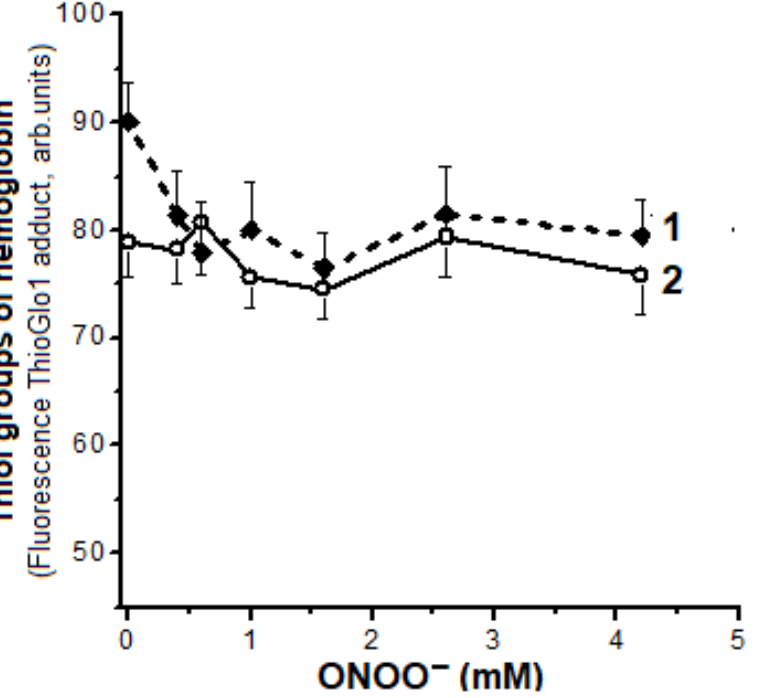
Figure 7. Influence of ONOO − on the amount of SH- groups of metHb detected by 10-(2,5-dihydro- 2,5-dioxo-1H-pyrrol-1-yl)-9-methoxy-3-oxo-H-naphtho[2,1-b]pyran-2-carboxylic acid–methyl ester (ThioGlo1), which forms an adduct with maximum fluorescence at 500 nm at an excitation wavelength of 379 nm. The ratio of metHb to ThioGlo1 in the reaction medium is 1:8 mM. Curve 1—metHb, 2—Hb-DNICs. The composition of the reaction medium, including ONOO − concentration, is the same as in the legend to Figure 3.